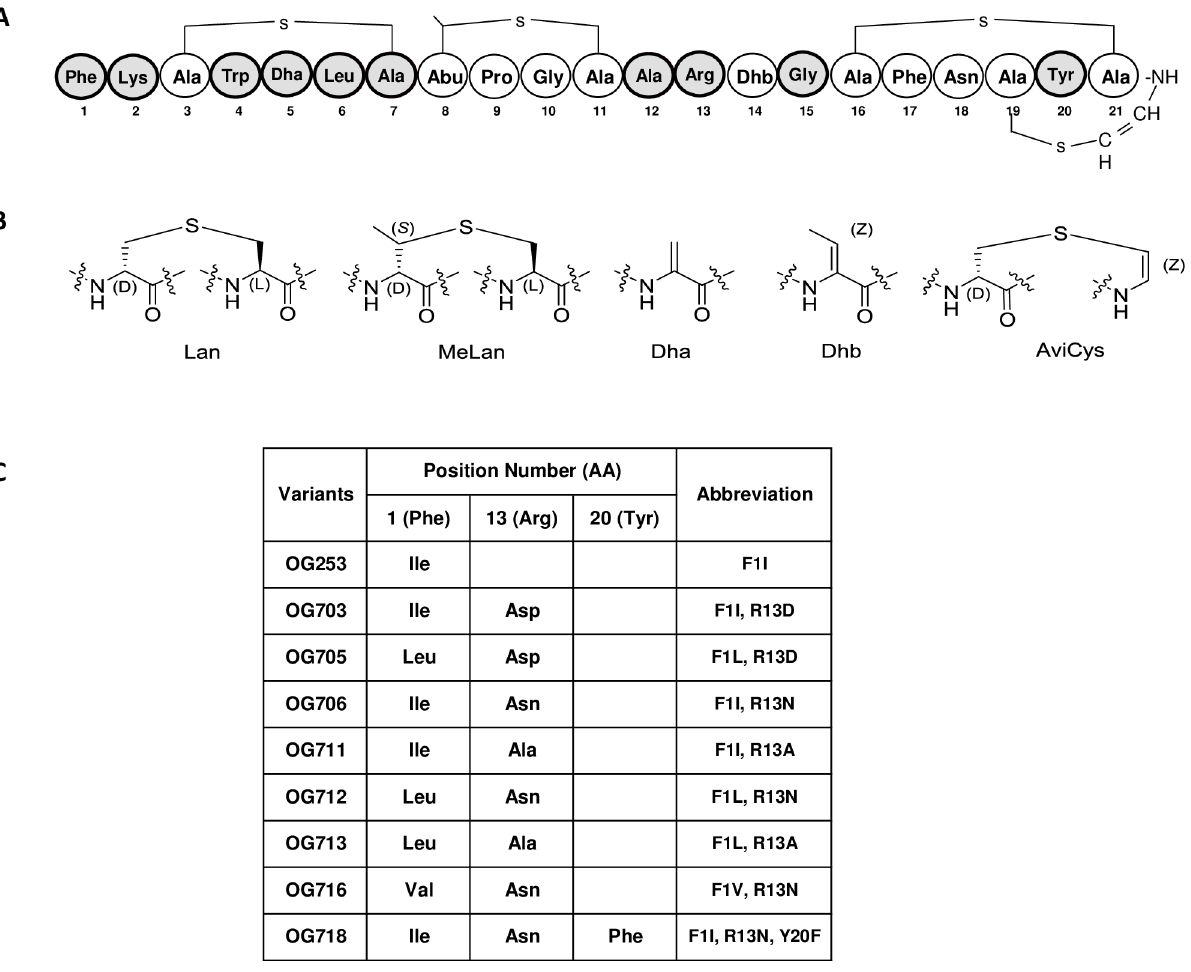
Fig 1. Structural features of MU1140 and select lead compounds. Panel (A) depicts the primary amino acid sequence of MU1140. The second generation of MU1140 variants designed in the current study focused on the residues highlighted in gray. Panel (B) depicts the structure of unusual amino acids. Panel (C) tabulates the substitutions of lead compounds carried through in vivo efficacy studies. Legend: amino acids, AA.